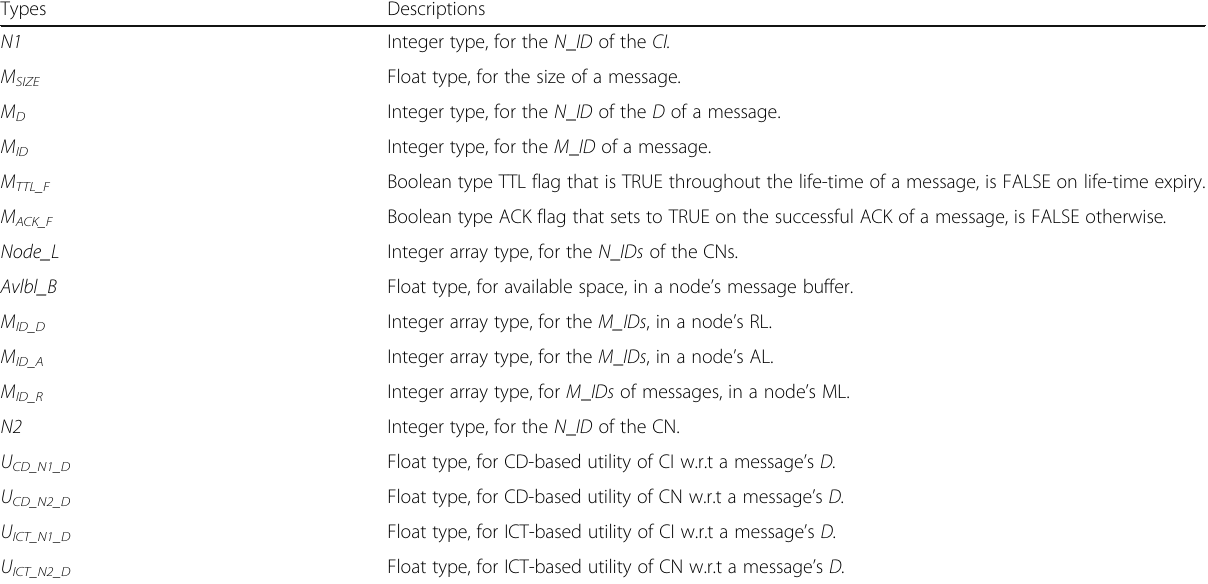
Table 5 Data types used in the model of